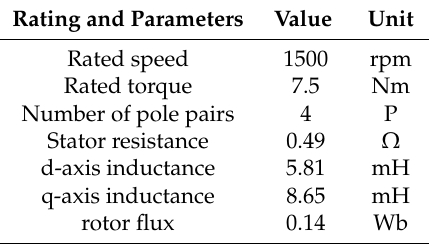
Figure 15. Photograph of the experimental setup. Table 1. Motor